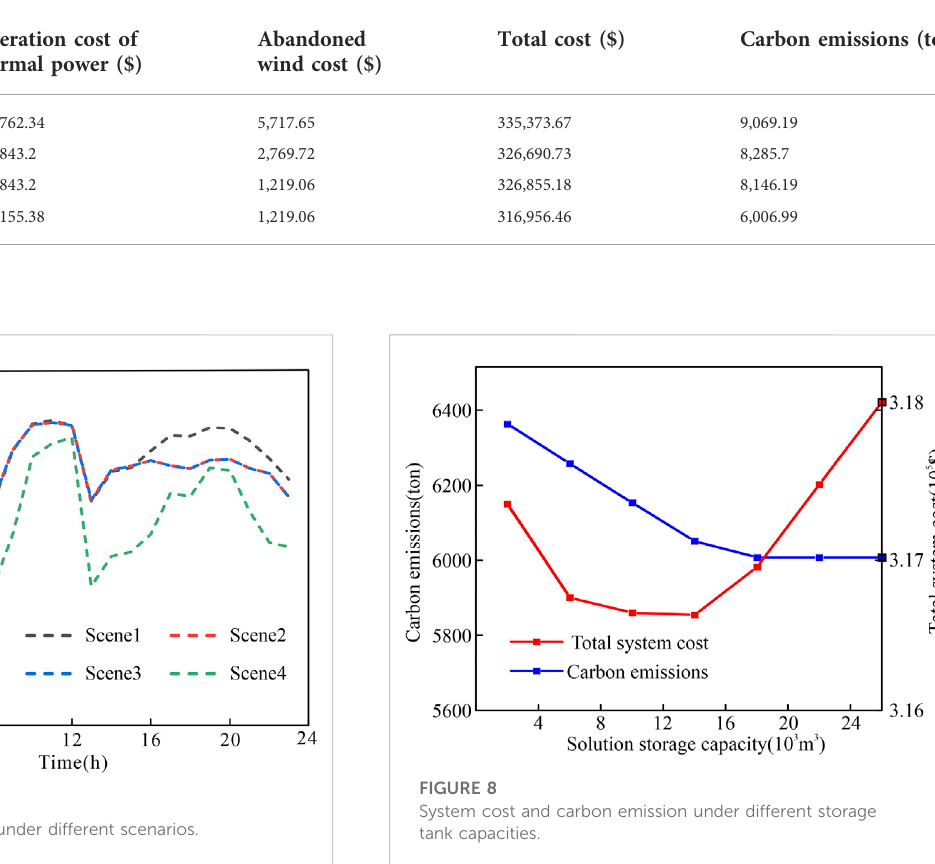
TABLE 2 System costs and carbon emissions in different scenarios.